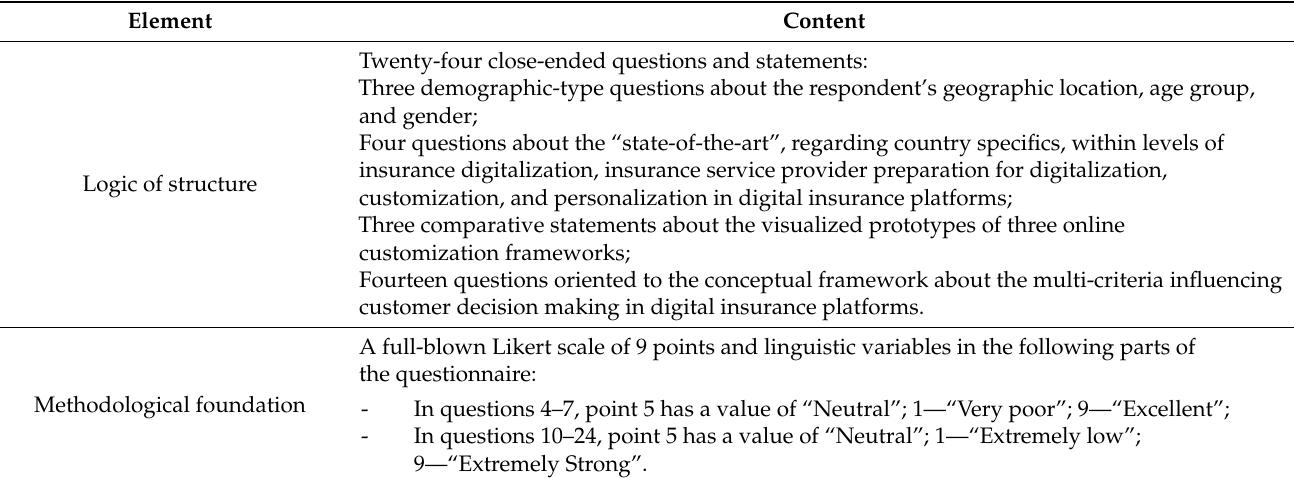
Table 2. Presentation of the questionnaire structure, content, and methodological foundation. Source: composed by the authors. Element Content